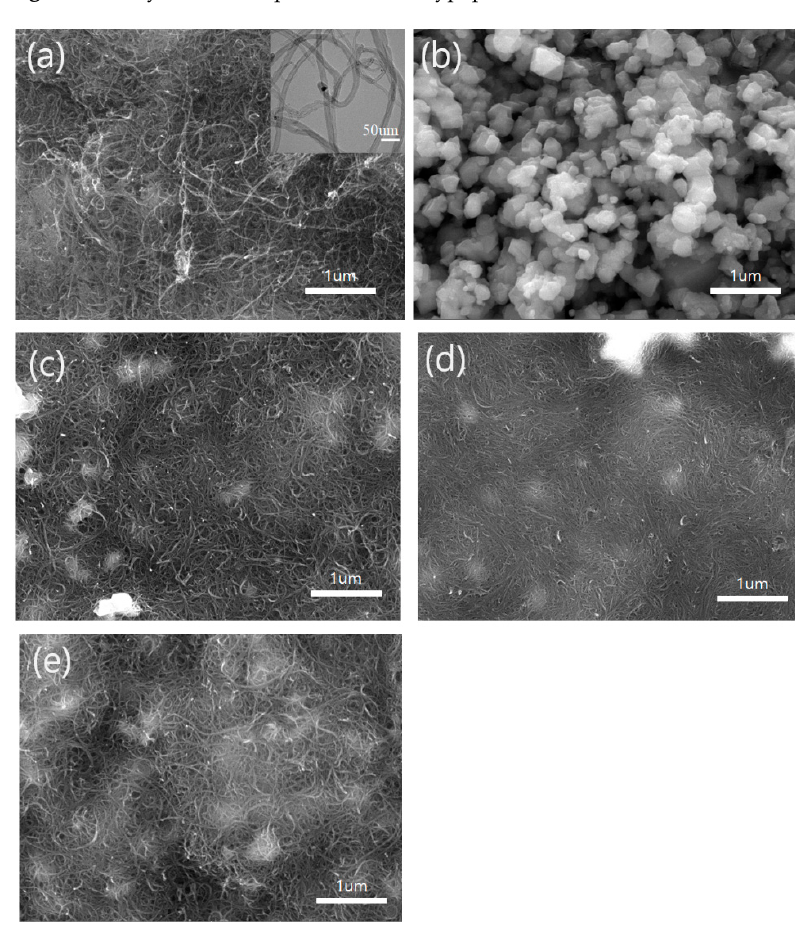
Figure 3. Field emission scanning electron microscopy surface images of ( a ) oxidized CNT powder and TEM image (inset), ( b ) LTO nanopowder, ( c ) LC40 film, ( d ) LC50 film, and ( e ) LC60 film.